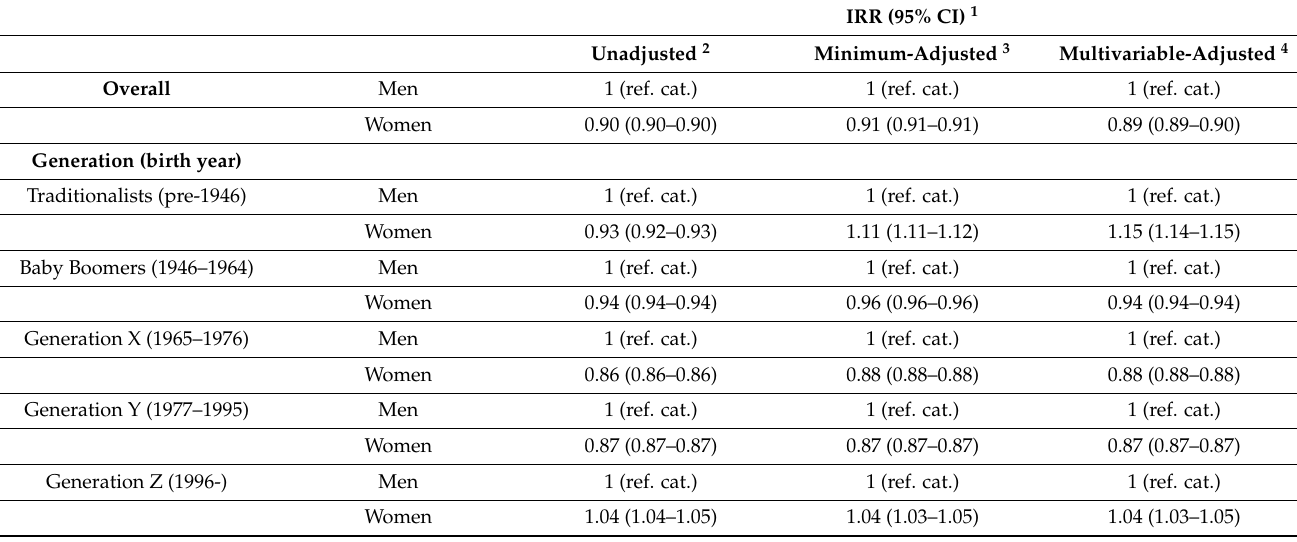
Table 4. Associations of sex with years in paid work, overall and by generation in Sweden from